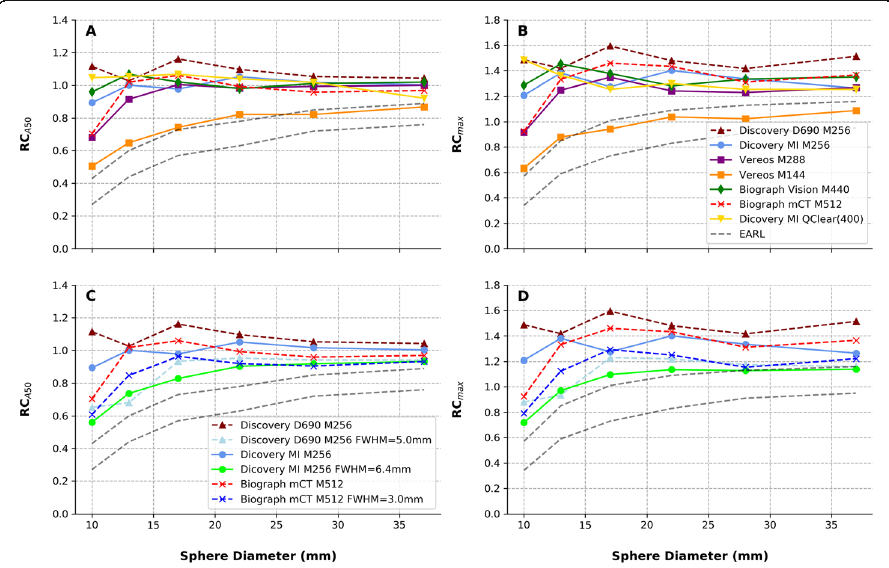
Fig. 4 RC A50 and RC max values as a function of the sphere diameter for acquisitions performed with a fixed scan duration of 180 s per bed position. Iterative reconstruction setups without Gaussian smoothing ( a and b ) and comparison of Gaussian vs. non-Gaussian setups for devices that used the Gaussian smoothing in the clinic ( c and d ). Digital devices were labeled with full lines and dashed lines represent the obtained results with analogue devices. Upper and lower RC boundaries specified by the EANM/EARL accreditation protocols are labeled with black dashed lines. EARL RC values (black dashed lines) refers to January 2017 version as reported in the EARL website